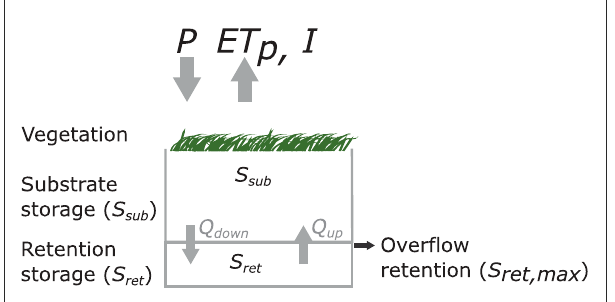
FIGURE1 Schematic of dual-layer green roof and GR2L model parameterization overview. P, ET p , and I correspond to precipitation, potential evapotranspiration, and